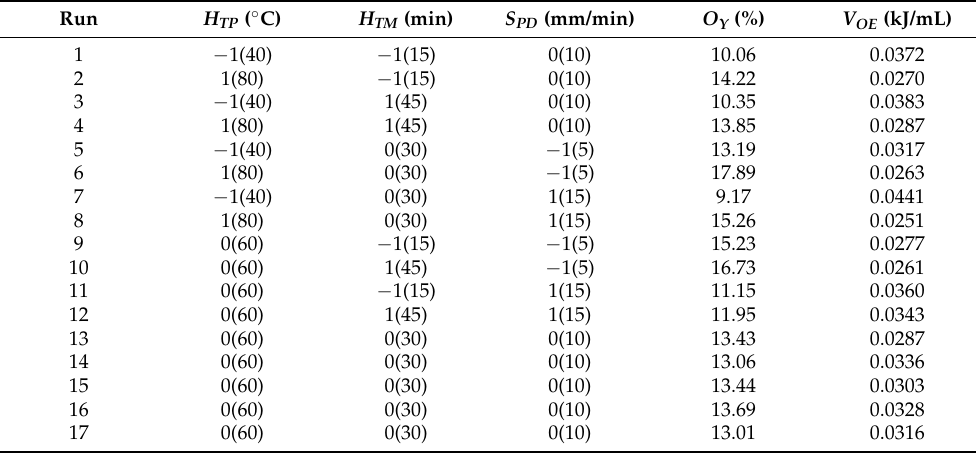
Table 4. Factor levels and calculated parameters under heating temperatures.